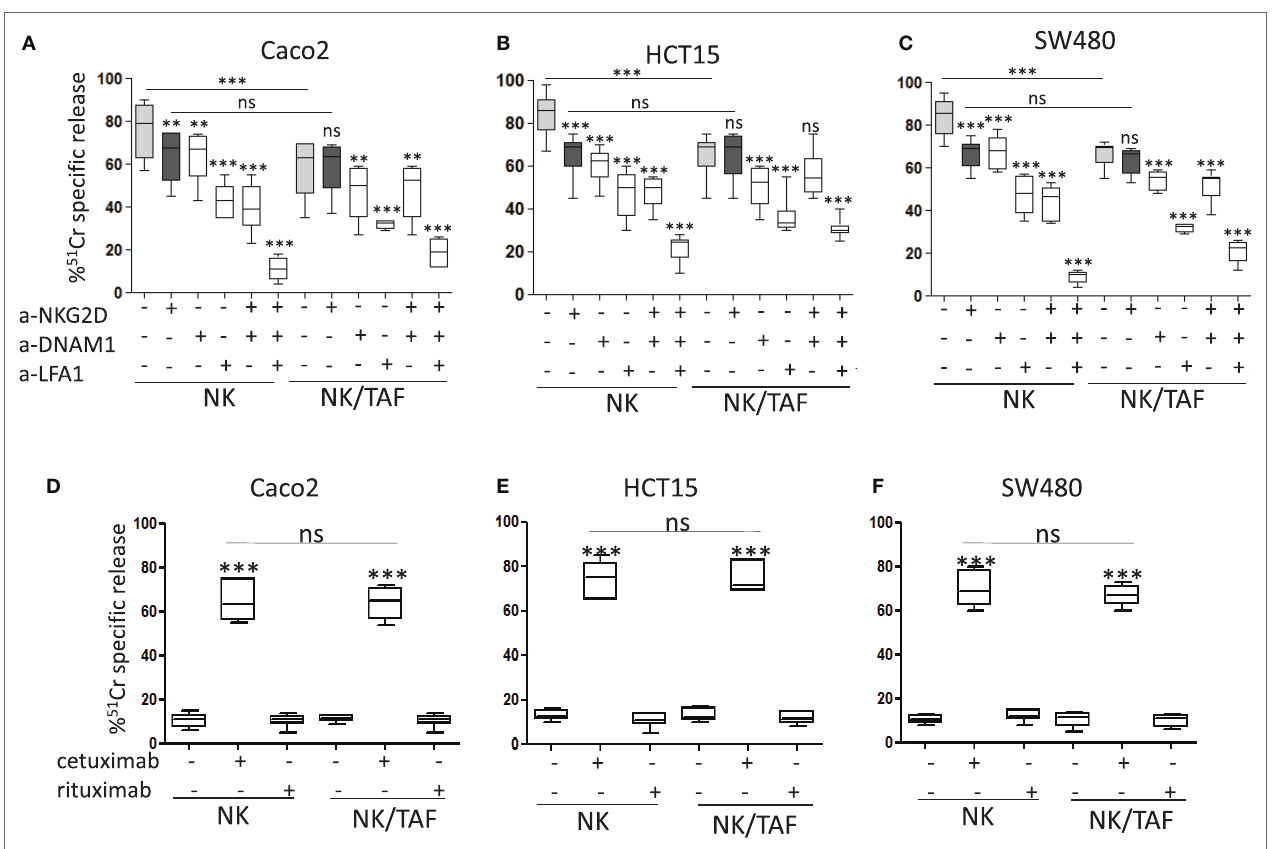
FigUre 1 | Natural killer (NK) cell killing of CRC lines is inhibited by tumor-associated fibroblasts (TAF). The carcinoma cell line Caco2 (a) , HCT15 (B) , and SW480 (c) were analyzed for their sensitivity to IL-2-activated NK cell mediated lysis [effector:target (E:T) ratio 20:1] without (light gray whiskers) or with monoclonal antibodies to NKG2D (dark gray whiskers) or DNAM1 or lymphocyte function associated (LFA)1 (2 µg/ml), alone or in combination. (D–F) NK cell activity (E:T ratio 5:1) against Caco2 (D) , HCT15 (e) , and SW480 (F) in the absence or in the presence of cetuximab or rituximab (2 µg/ml). NK cells were either cultured alone (NK) or derived from co-cultures with mesenchymal stromal cells from CRC mucosa (NK/TAF). Results are shown as percentage of 51 Cr-specific release and they are the mean with boxes and whiskers min to max of six experiments with NK cells derived from six distinct co-cultures with TAF. In each panel: *** p < 0.0001; ** p < 0.001; ns, not